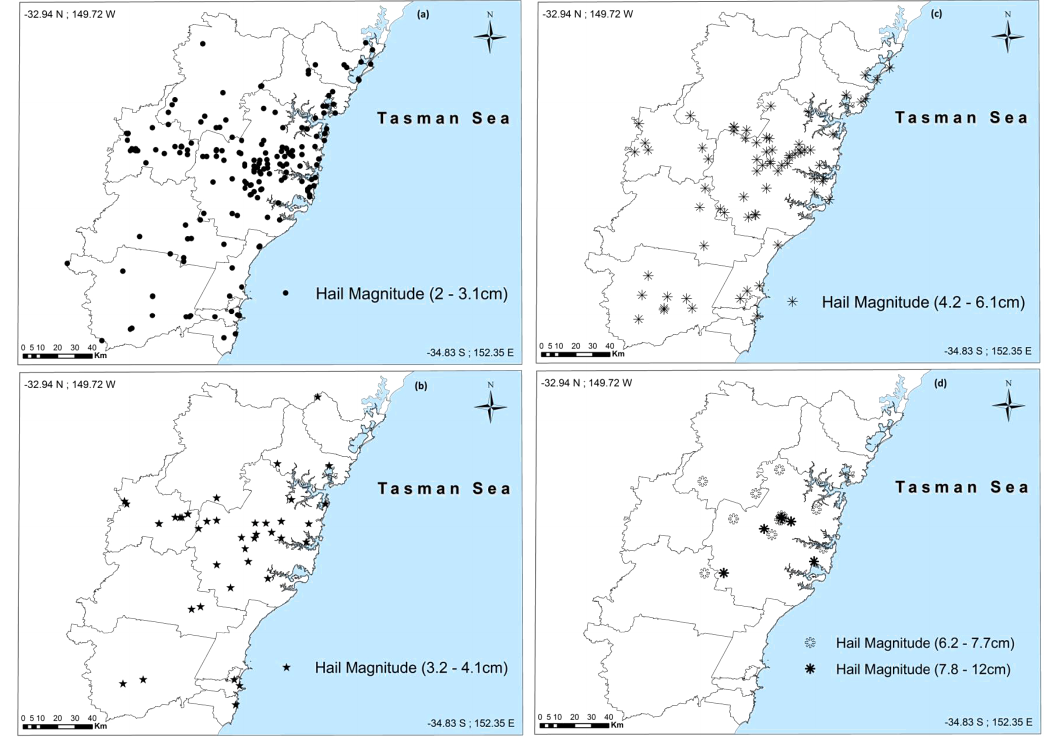
Figure 11. Spatial distribution of hail with magnitude category (a) 2–3.1cm, (b) 3.2–4.1˙cm, (c) 4.2–6.1cm and (d) 6.2–7.7 and 7.8–12cm.